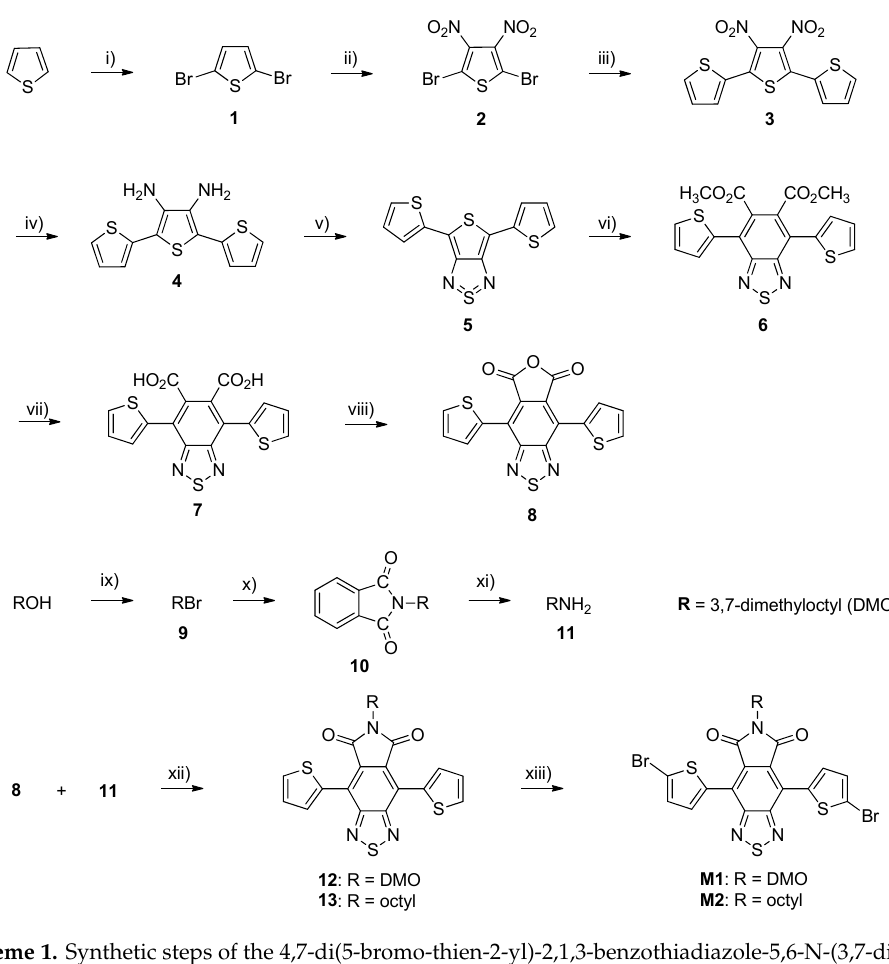
and M2), respectively. The polymerizations were performed using